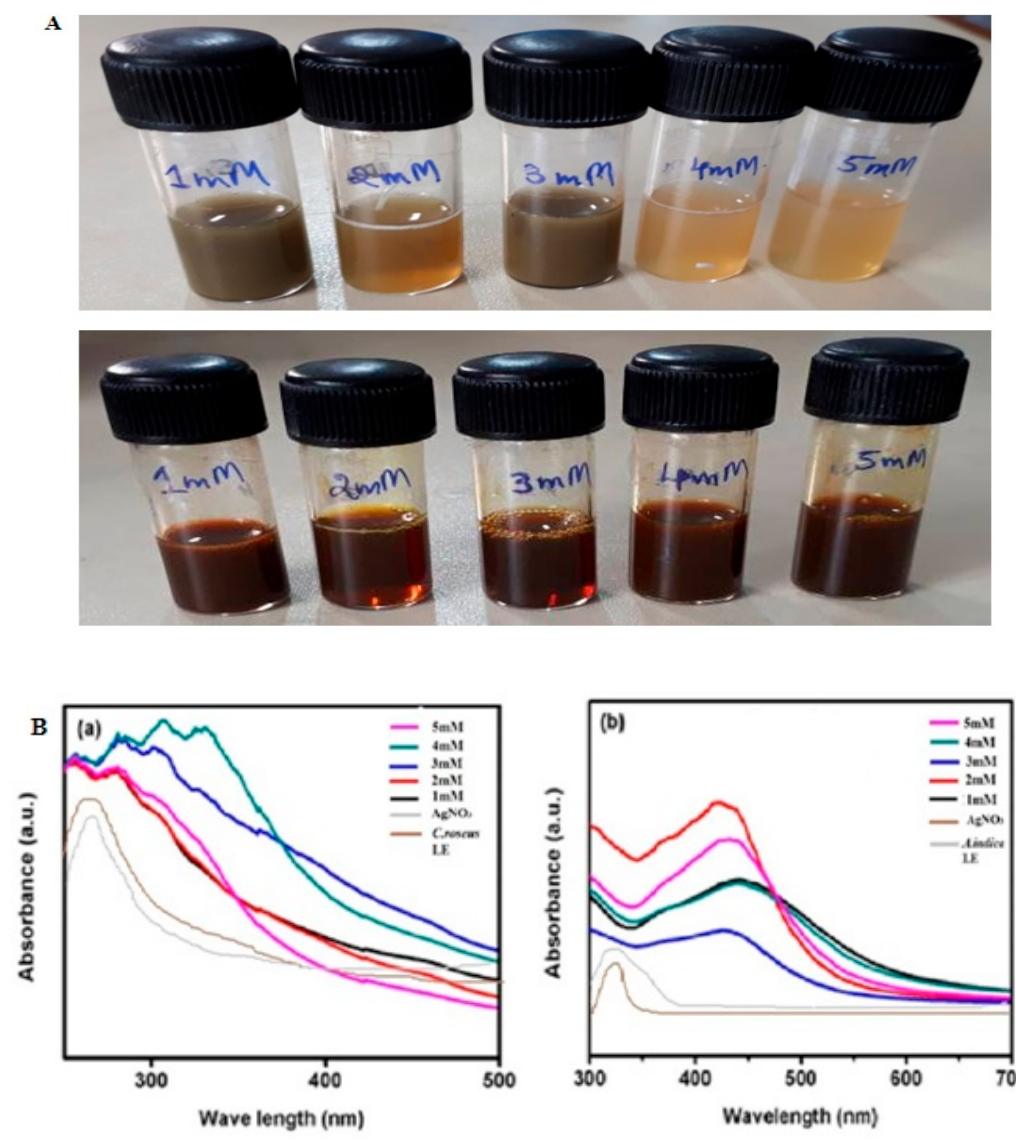
Figure 1. ( A ) Bioreduction of silver nanoparticles from Catharanthus roseus (top panel) and Azadirachta indica (bottom panel) leaf extracts. ( B ) UV–Vis spectroscopy analysis of biosynthesized silver nanoparticles of Catharanthus roseus ( a ) and Azadirachta indica ( b ) plant leaf